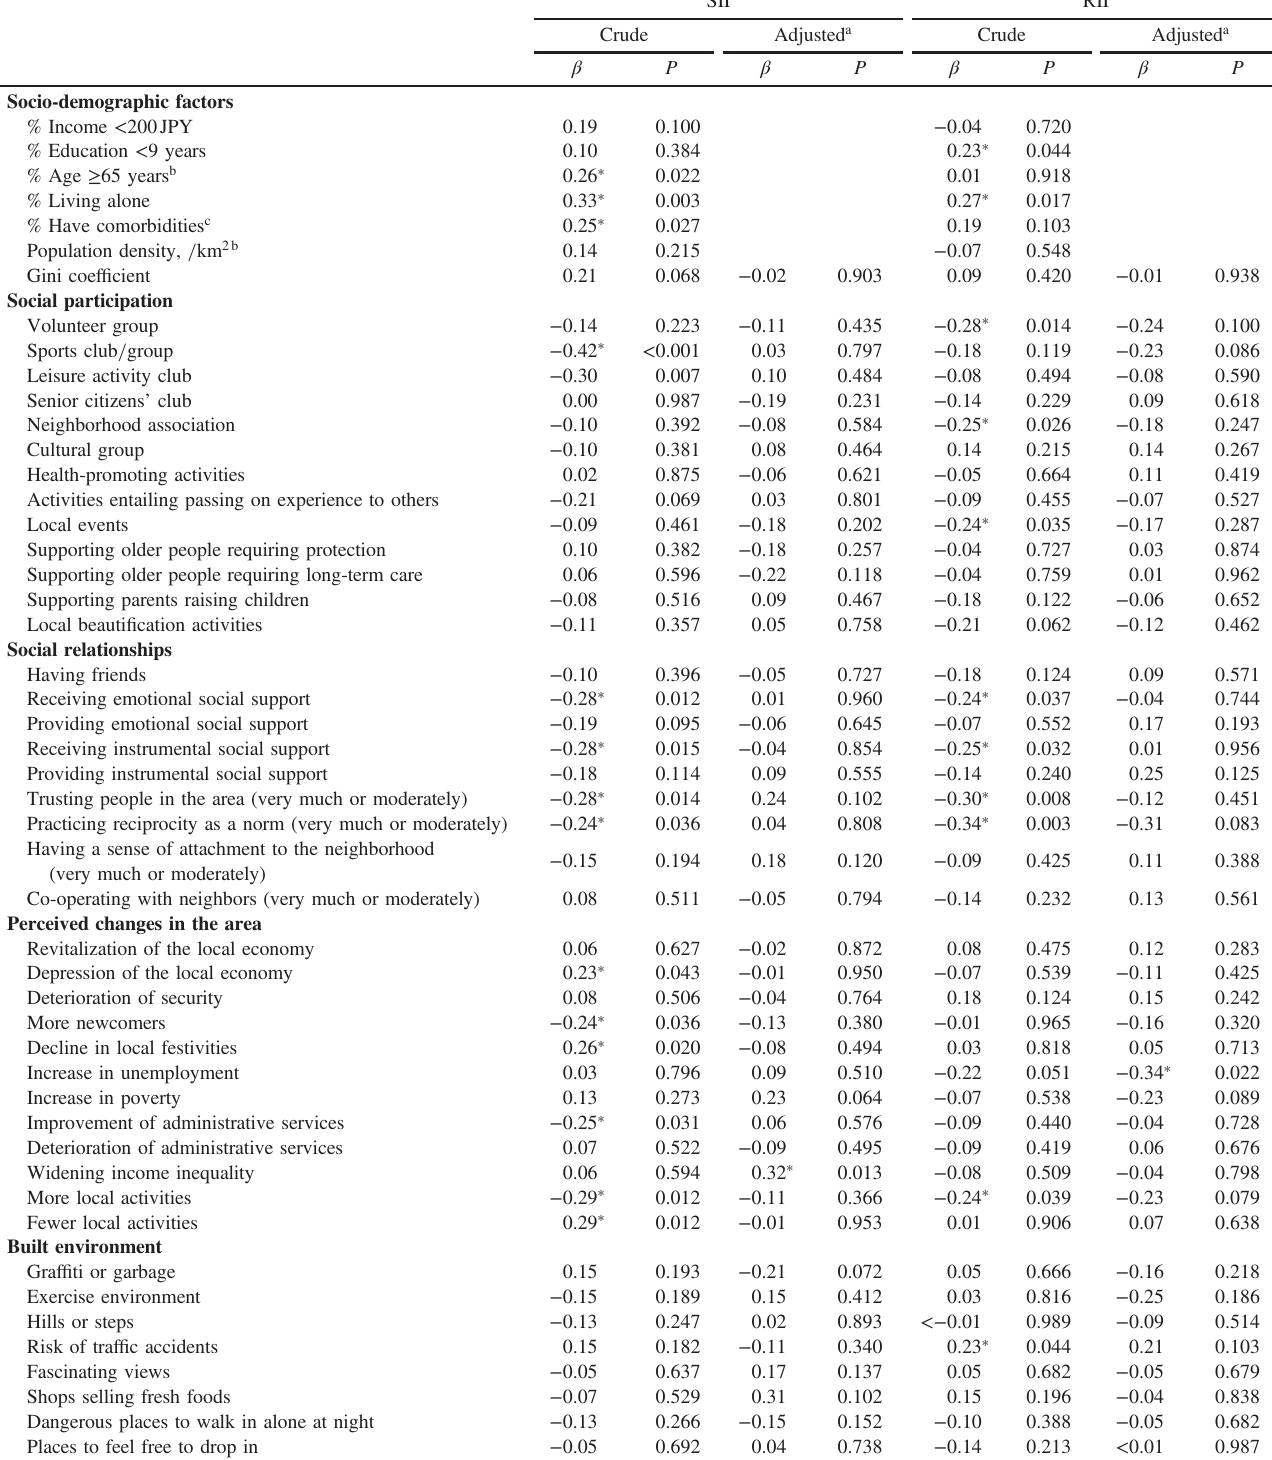
Table 4. Association between income-based health inequality indices (slope index of inequality [SII] and relative index of inequality [RII]) in depressive symptoms by 1 standard deviation unit increase in community characteristics measures among older Japanese women ( n = 52,958): result of multiple